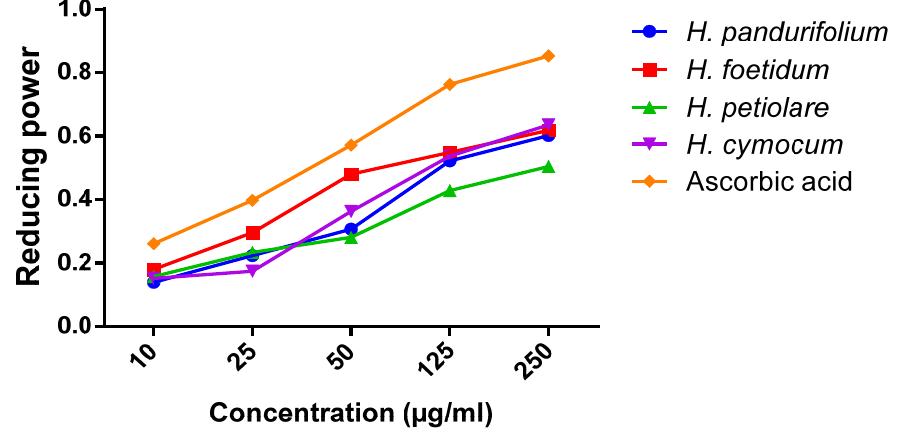
Figure 3. Reducing power activity of aqueous acetone extract of H. pandurifolium, H. foetidum H. petiolare, and H. cymocum .